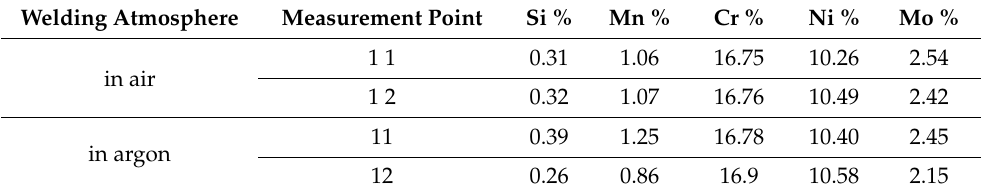
Table 3. Percentage content of selected alloying elements at measurement points.